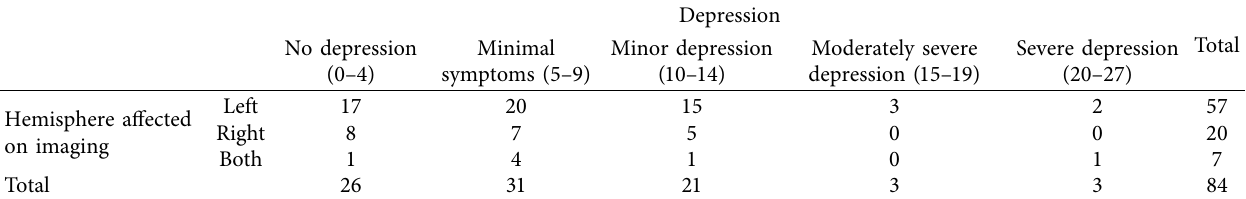
Table 3: Frequency distribution of depression with hemisphere affected on imaging among stroke patients at TASH and ZMH neurology